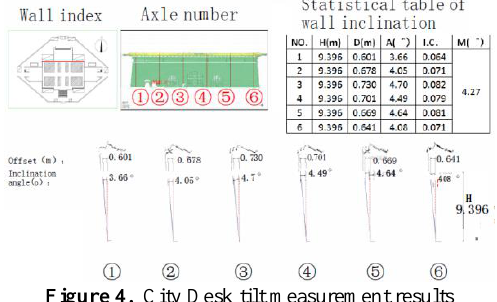
Figure 4. City Desk tilt measurement results